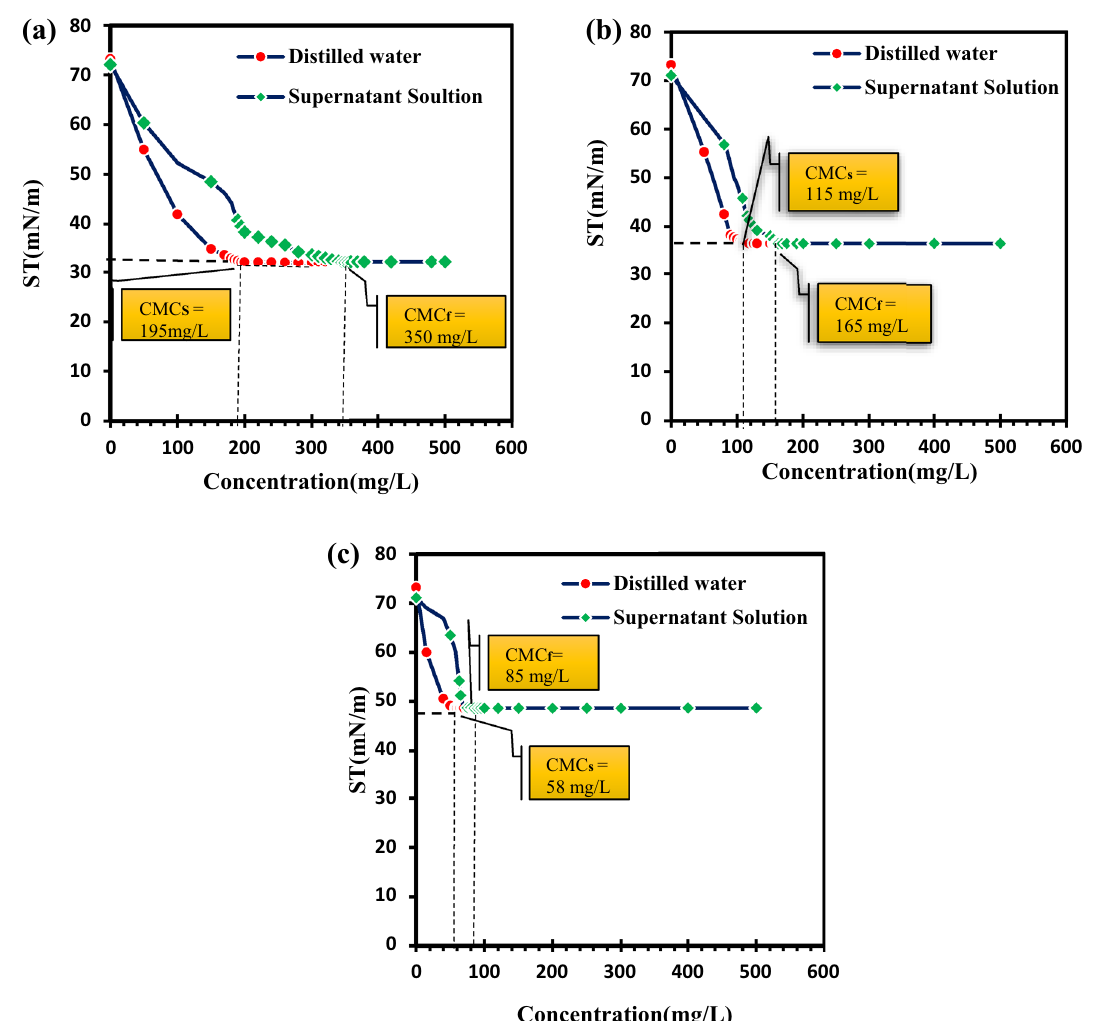
Figure 3. ( A,B ) represent the adsorption of produced biosurfactants into the contaminated soil by SH21 and SHA302, respectively, in different concentrations. ( C ) Adsorption of produced bioemulsifier into the contaminated soil by SH72 in different concentrations. CMC s measured CMC in distilled water before adding it to the soil, CMC f measured CMC after adding the surfactant to the soil (adsorption of surfactant to the soil is obtained from the difference between these two